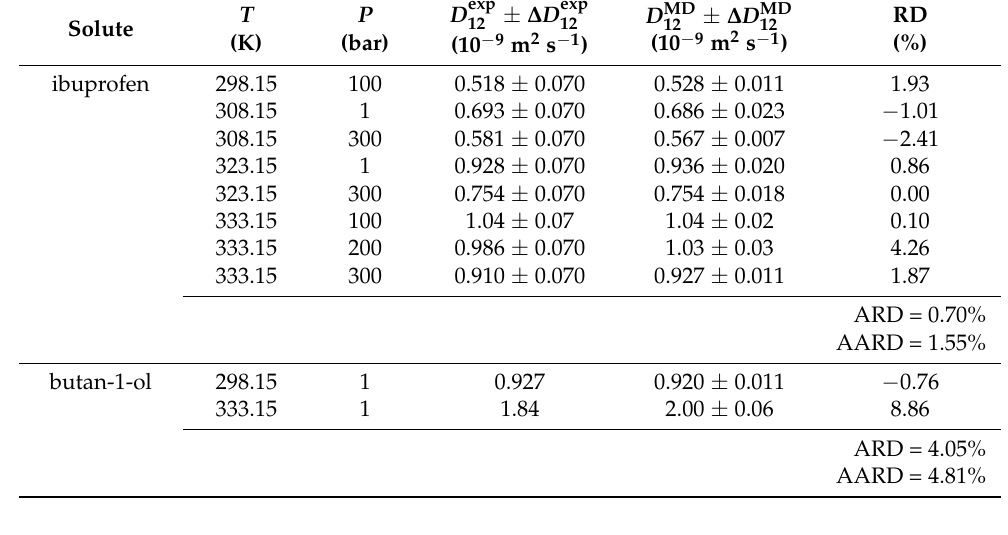
Table 2. Experimental ( D exp ) and computed ( D MD ) diffusion coefficients of ibuprofen and butan- 12 12 1-ol in liquid ethanol at various temperatures and pressures. The computer simulations used σ OH = 0.306 nm for ethanol, and the calculated diffusivities were evaluated in comparison with experimental data in terms of the relative deviation (RD), average relative deviation (ARD), and average absolute relative deviation (AARD).